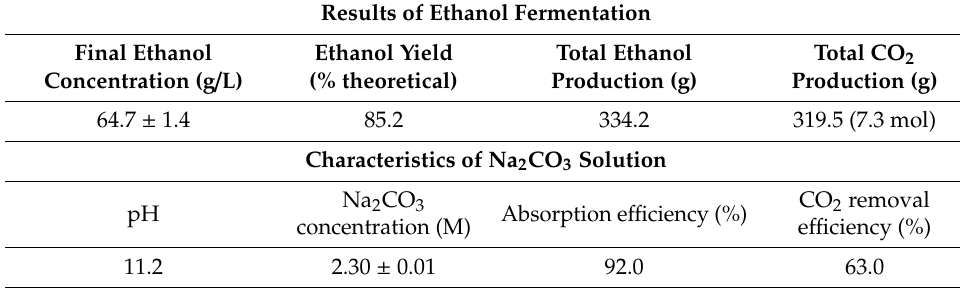
Table 1. The results of SSJ ethanol fermentation and capture of the produced CO 2 by absorption in 5 M NaOH solution.